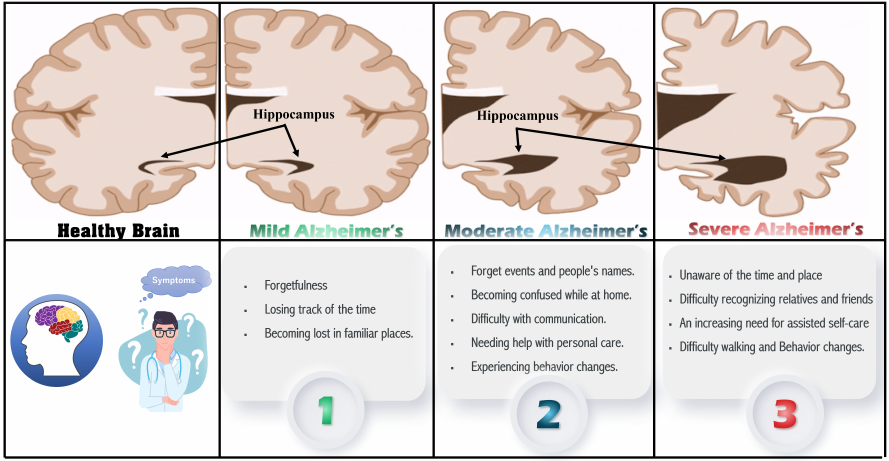
Figure 2. The major signs and symptoms of